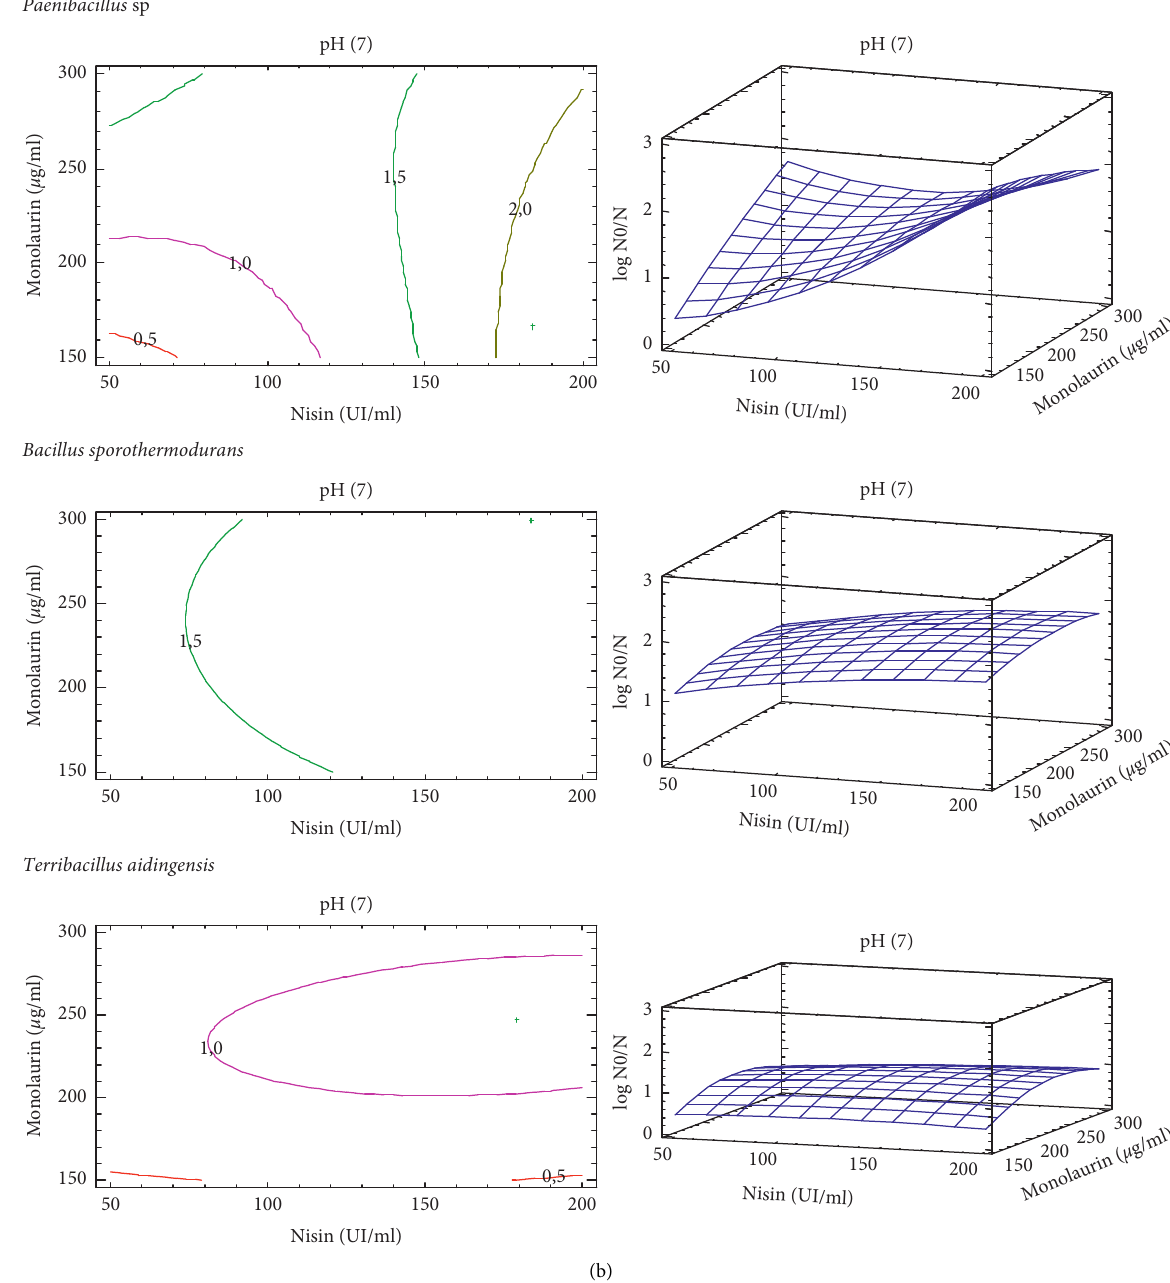
Figure 1: Response surface and contour plots showing the effects of nisin and monolaurin on the spores’ inactivation in distilled water (a) and milk (b). The data on the contour maps are log N 0 /N. N 0 represents the plate count of the untreated spore suspension (10 7 spores/ml), and N represents the plate count after treatment with antimicrobial